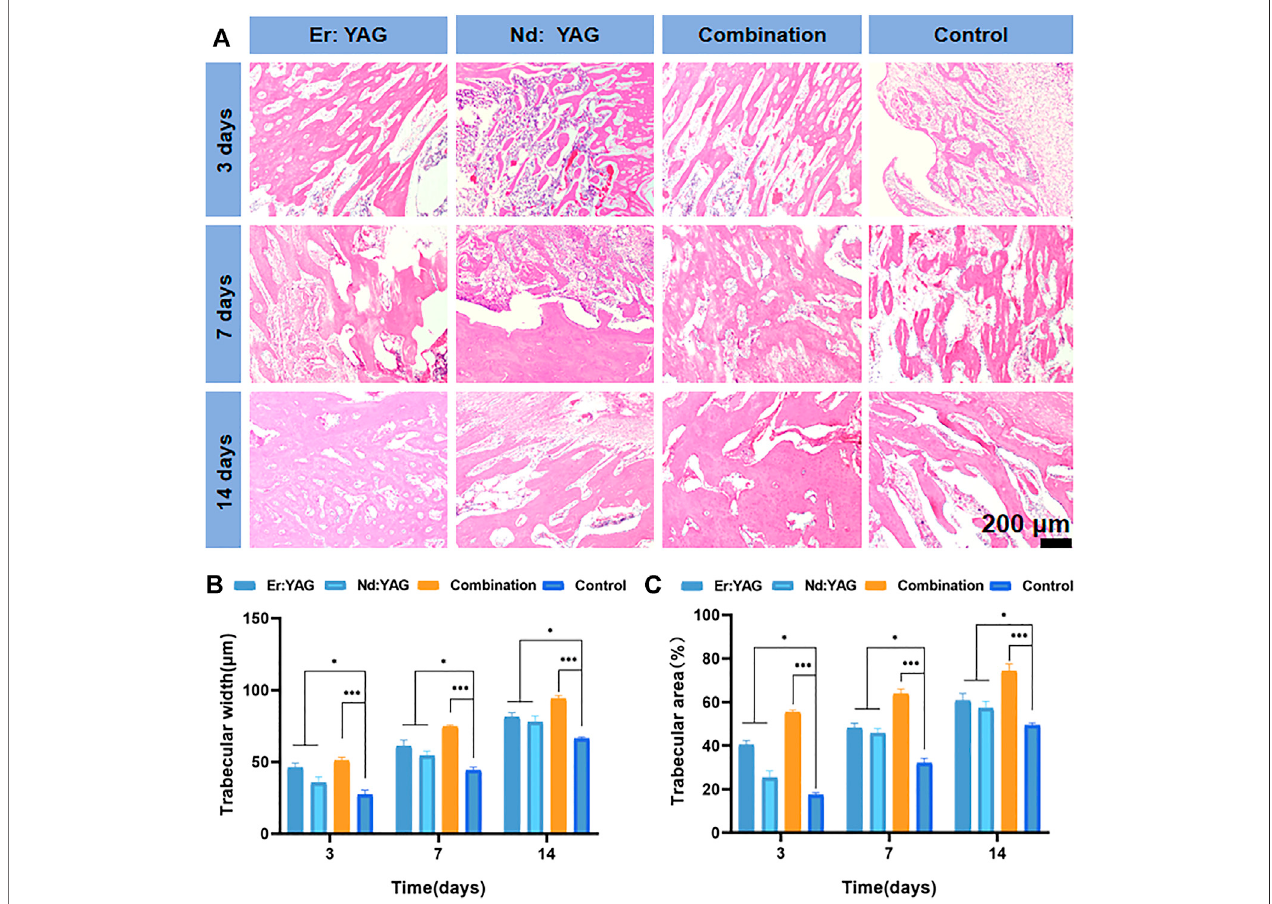
FIGURE 2 | Histological analysis of bone integration. Representative images of (A) HE staining of the defect site after 3, 7, and 14 days of implantation (pink in HE staining shows collagen fi bers of the new bone at the interface between the implant and bone), trabecular width of the regenerated bone (B), and the area of the regenerated bone, following (C) HE staining ( n = 3, *indicates signi fi cant differences between the groups, * p < 0.05; ** p < 0.01; *** p < 0.001).